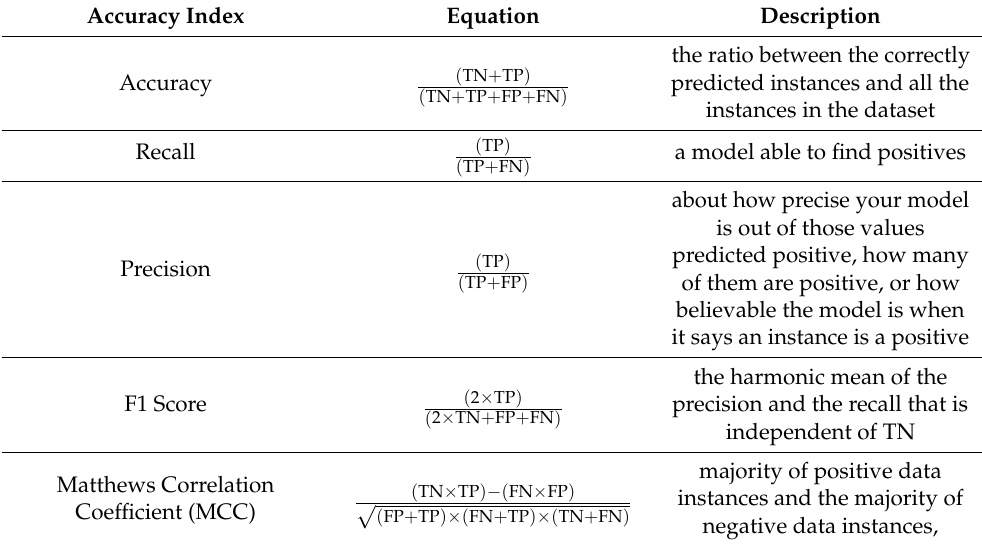
Table 5. The metrics used for the accuracy assessment of the building damage detection.